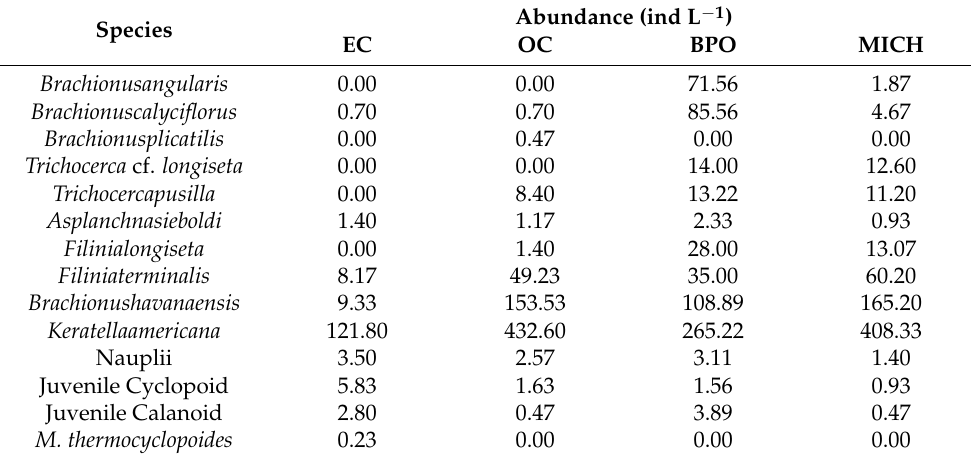
Table 2. Abundance (ind L − 1 ) calculated from zooplankton samples for all the studied points of Lake Amatitl á n in